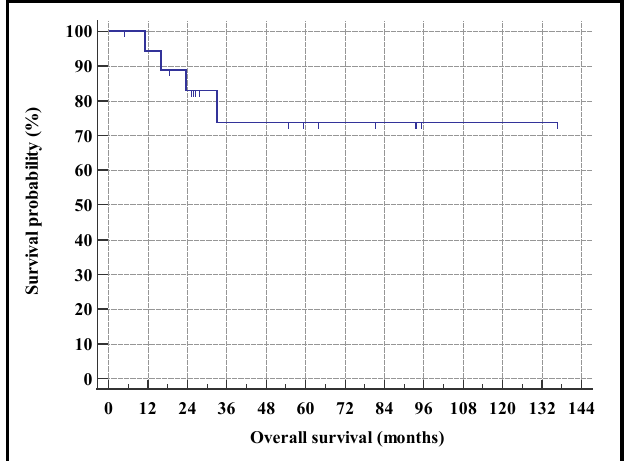
Figure 2: Kaplan-Meier curve of overall survival of 19 children with vaginal rhabdomyosarcoma The four relapsed RMS patients received a second-line (ifosfamide, carboplatin, and etoposide